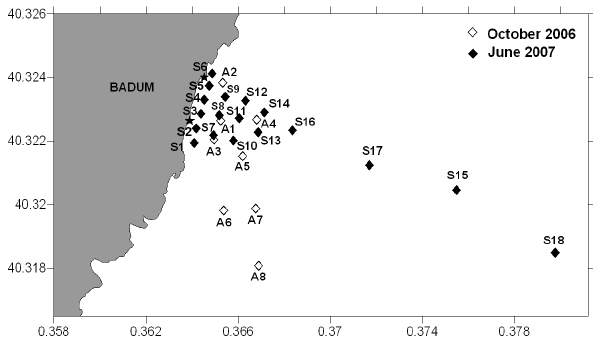
Figure 2 764 765 Fig. 2. Water stations in the Badum coastal area corresponding to October 2006 (open squares) and June 2007 samplings (solid squares). The stars indicate the sampled coastal